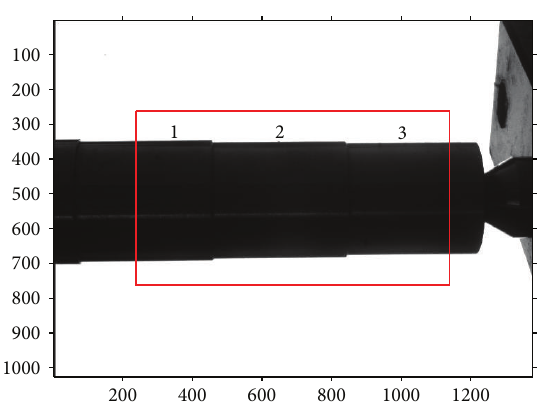
Figure 11: The imaging of one-segment